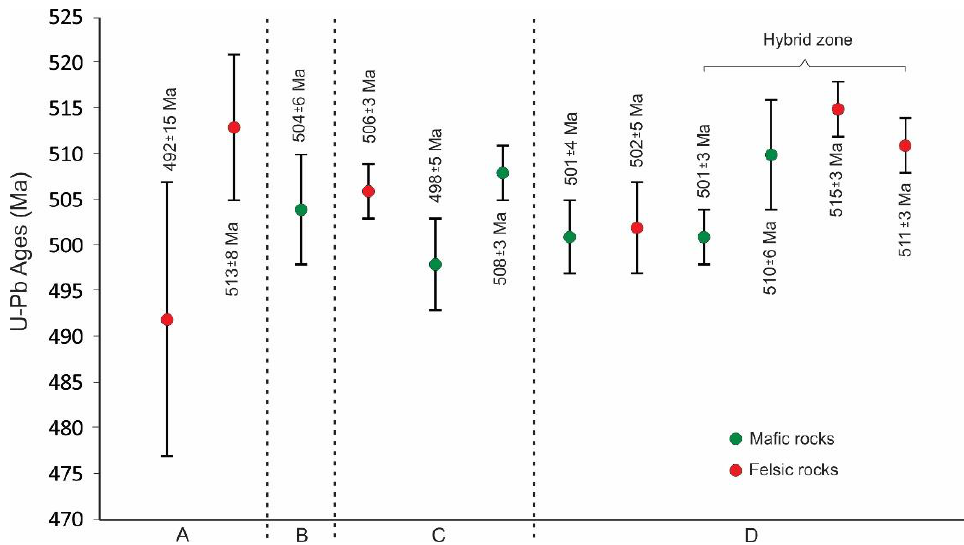
Figure 11. U – Pb ages presented for the Santa Angelica Intrusive Complex. A — [11] — ID-TIMS; B — Figure 11. U–Pb ages presented for the Santa Angelica Intrusive Complex.